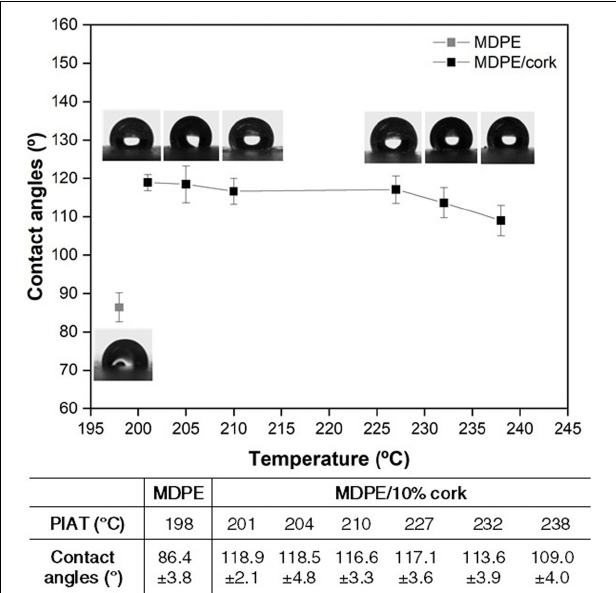
FIGURE 7 | Contact angles between a drop of water and the surface of virgin MDPE and MDPE/10% cork parts.